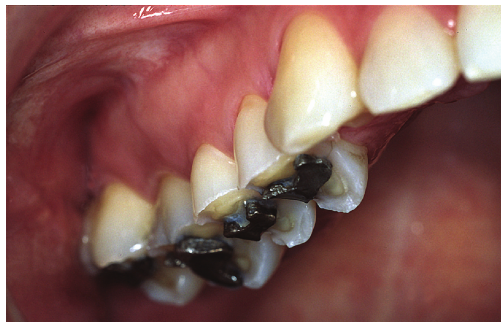
Figure 6: A 40-year-old woman with inoperable hiatus hernia, and despite long-term antireflux medication developed severe damage on her posterior teeth. Note the relatively intact amalgam fillings “raised” above the eroded occlusal surfaces [11].